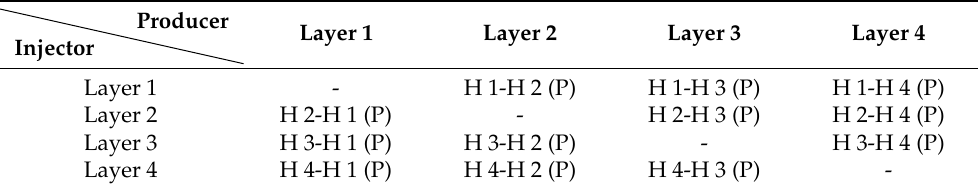
Table 9. Well pattern descriptions of the H-H (P)